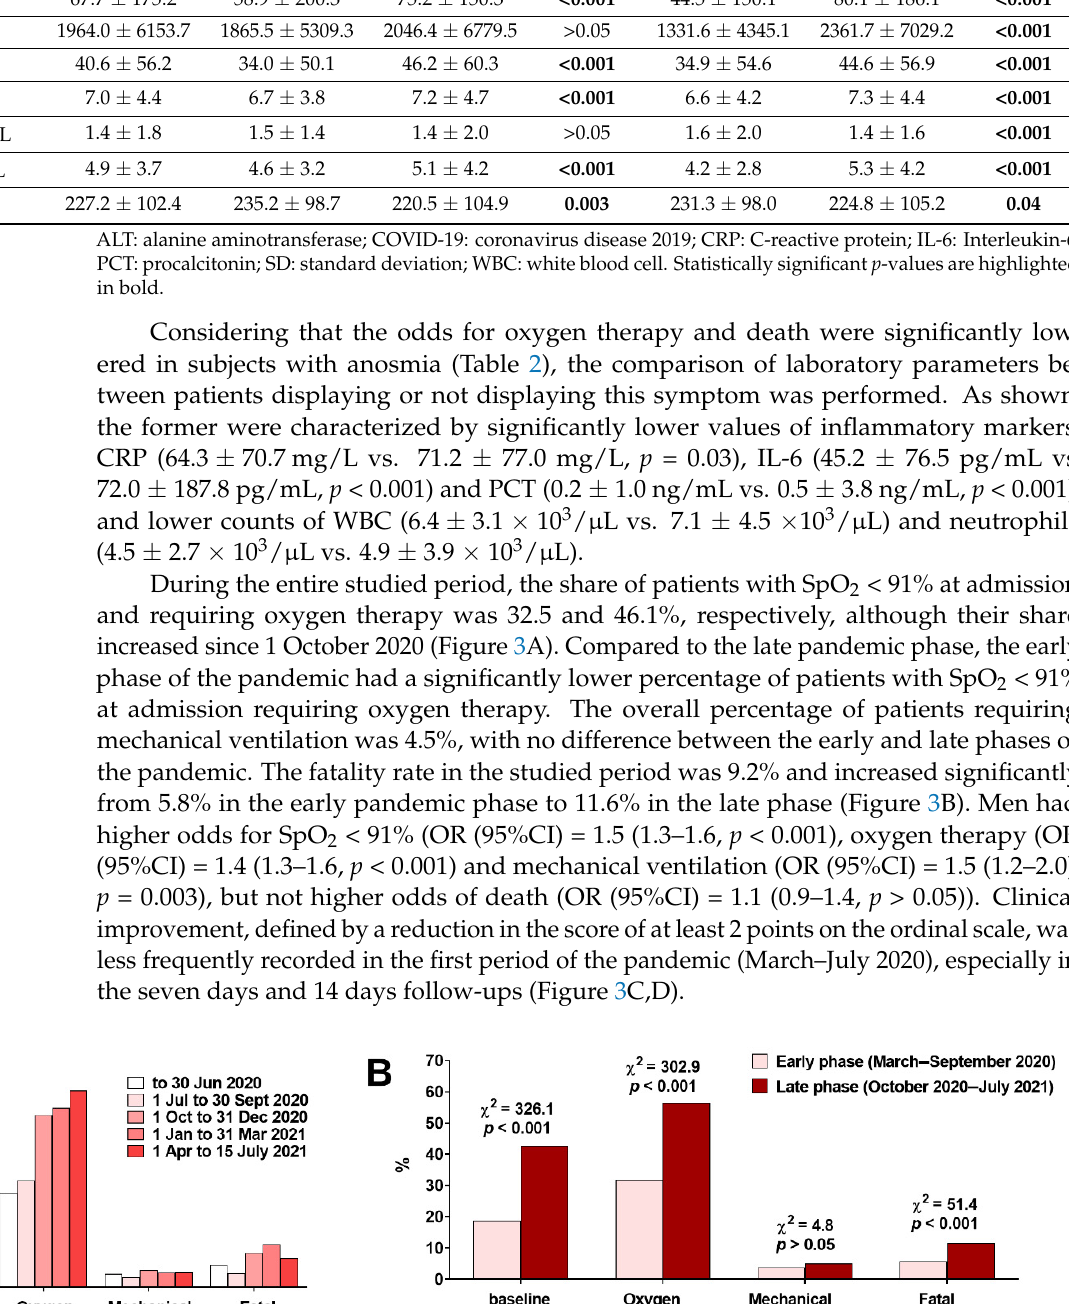
Figure 3. ( A ) The frequency of patients with baseline SpO 2 < 91%, requiring oxygen therapy and mechanical ventilation, and with fatal outcome in different periods of the pandemic ( n = 5199) and ( B ) comparison of these events between the early and late phase of the pandemic. ( C ) Percentage of patients with improvement in the clinical course of COVID-19 defined as a reduction in the score of at least 2 points on the ordinal 8-score scale (see Material & Methods for a detailed explanation of each score) in different periods of the pandemic and ( D ) comparison of these percentages between the early and late phase of the pandemic. 4. Discussion This study provides a comprehensive overview of the COVID-19 patients hospitalized in Poland over the first 17 months of the pandemic and a reference point for further epidemiological analyses and comparisons. Consistent with various other observations, the investigated cohort was characterized mainly by elderly subjects suffering from at least one comorbidity, slightly more frequently represented by men. The conducted analysis indicates some potential changes in pathogenicity of SARS- CoV-2 after September 2020, manifested by an increased share of patients with SpO 2 < 91% and requiring oxygen therapy. The frequency of cough, fever, dyspnea also increased in later pandemic phases compared to the first three months. In general, the frequency of all considered symptoms except headache was higher in the late phase of the pandemic (October 2020–July 2021). Moreover, this phase was also characterized by patients exhibiting significantly increased levels of inflammatory markers, including IL-6, as well as differences in blood morphology: higher WBC and neutrophils counts but lower counts of lymphocytes and platelets. This may be due to the increase of the G superclade frequency in SARS-CoV-2 variants circulating in Poland in 2020[16]. Its hallmark D614G substitution in spike protein was associated with increased transmissibility and higher viral loads [17]. Although the general human mortality was not found to be affected by D614G mutation, the animal studies demonstrated a modest increase in virulence—this slight increase may also be reflected in our observations [17,18]. According to some studies, infections with the B.1.1.7 (alpha) variant could be associated with higher mortality, although this was contradicted by other observations [18,19]. There have been some concerns, magnified by media reports, that the B.1.1.7 (alpha) variant may have a larger impact on the younger population by leading to a more severe clinical course of COVID-19 [20]. According to the national genomic surveillance,